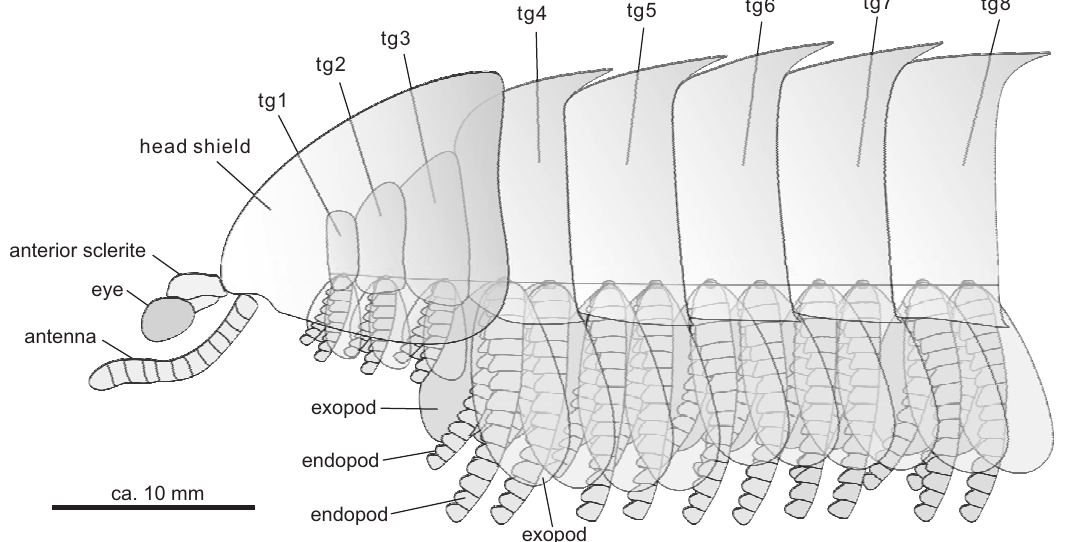
Fig. 4. Schematic reconstruction of a lateral view of the anterior body region (tg1–tg3, anterior reduced segments) of a generalized Guangweicaris . Abbreviations: tg,